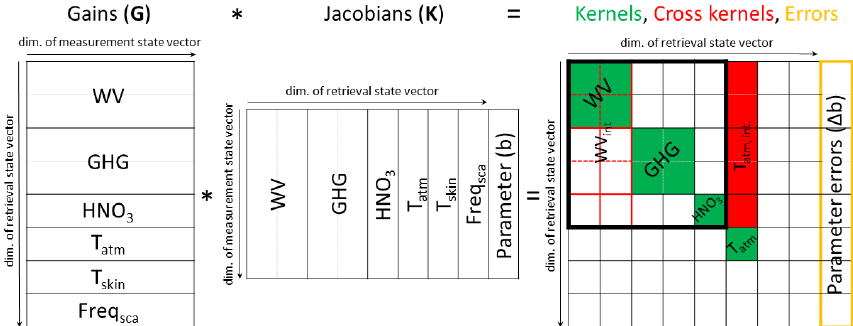
Figure 8. Schematic explanation of the gain and Jacobian matrices provided in the extended netCDF output file and the kernel and cross kernel matrices (indicated as the matrix blocks filled by green and red colour, respectively) provided in all netCDF output